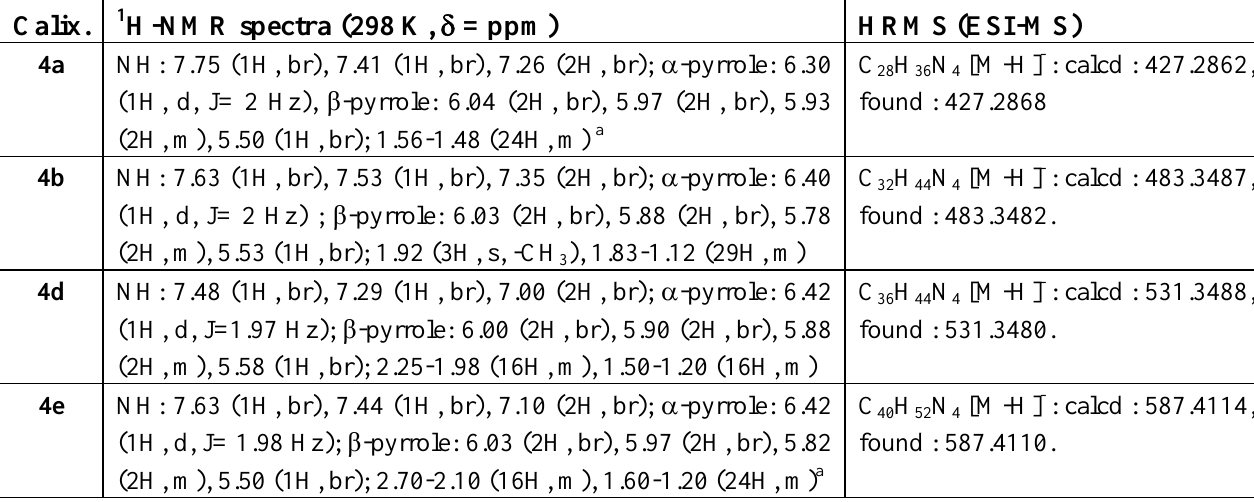
Table 4: 1 H-NMR and mass spectra of meso-octaalkyl and cycloalkyl N -confused calix[4]pyrroles 4a, 4b, 4d, 4e .